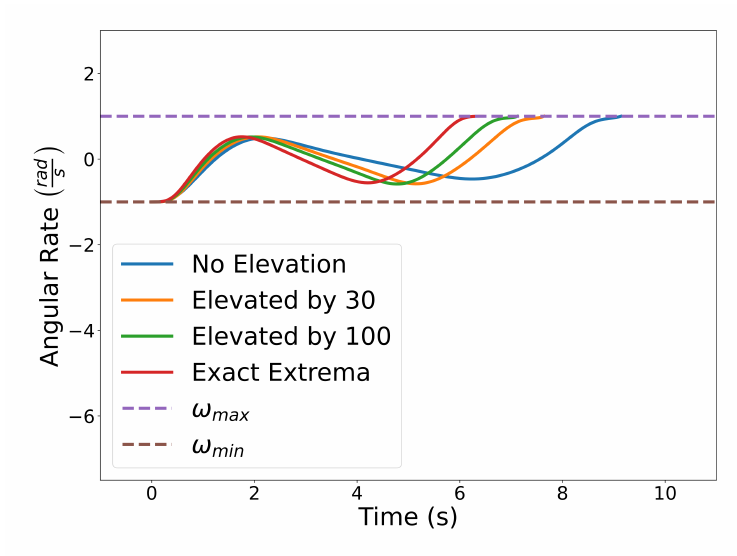
Figure 25. Plot of the angular rate constraints for each separate